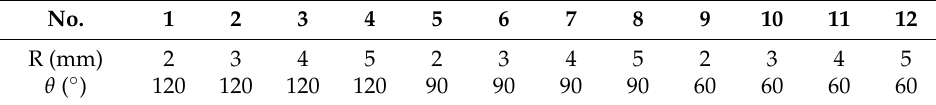
Table 5. The diameters (R) and taper angles ( θ ) of pit defects.